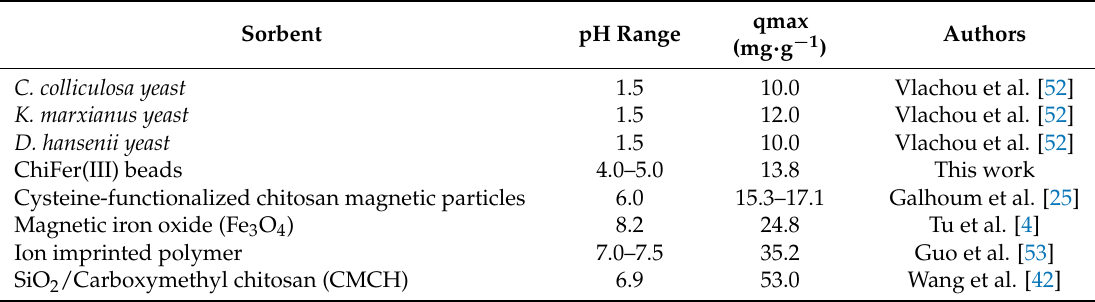
Table 2. Comparison of sorption capacities for several